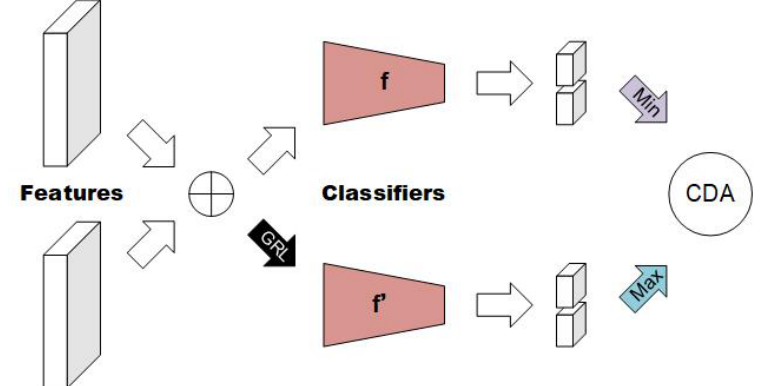
Figure 3. This figure illustrates the cross-domain feature alignment module, which aligns sample features from two domains by minimizing the divergence between them. Adversarial learning is employed to achieve the alignment, where two identical classifiers, denoted as f and f (cid:48) , are trained to perform the same classification task on the aligned features. Adversarial learning is formulated as a minimax game. During the maximization process, the gradient of the input feature is inverted before being fed to the classifier to ensure the alignment of the two domains. The optimized result is denoted as “CDA” at the end of the